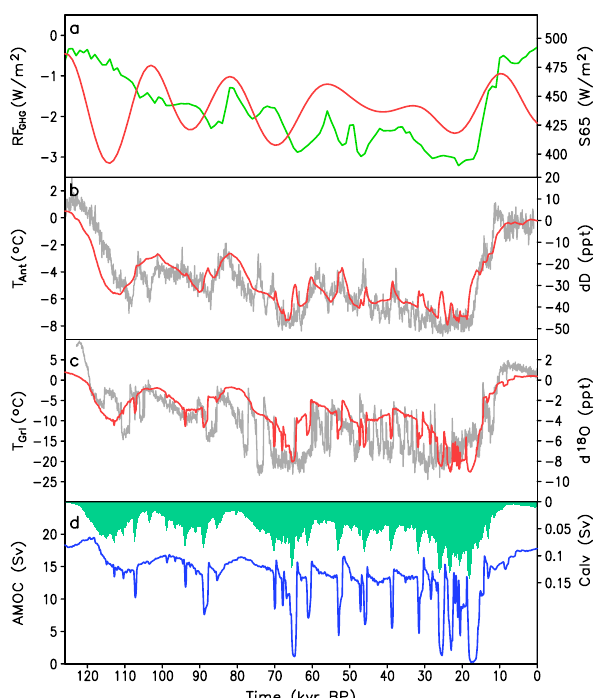
Fig. 8. Climate forcing and climate evolution. (a) Prescribed radia- tive forcing of GHGs (green) and orbital forcing (red) represented by changes in maximum summer insolation at 65 ◦ N. (b) Simulated annual anomalies of East Antarctic temperature (red) and anomaly of the deuterium concentration from the EPICA ice core (grey). (c) Simulated annual anomalies of the North Atlantic (60 ◦ –70 ◦ N) temperature (red) and measured anomaly of the δ 18 O concentration from the NGRIP ice core (grey). (d) Simulated rate of Atlantic out- flow at 30 ◦ S (blue) and total ice calving (green). Note the reverse direction of y-axis for the ice calving. The anomalies in (b) and (c) are relative to present-day. Although the empirical data are ar- bitrarily scaled to achieve the best fit with the modelled data, the relationships between temperature variations and isotope variations are close to those used for palaeoclimate